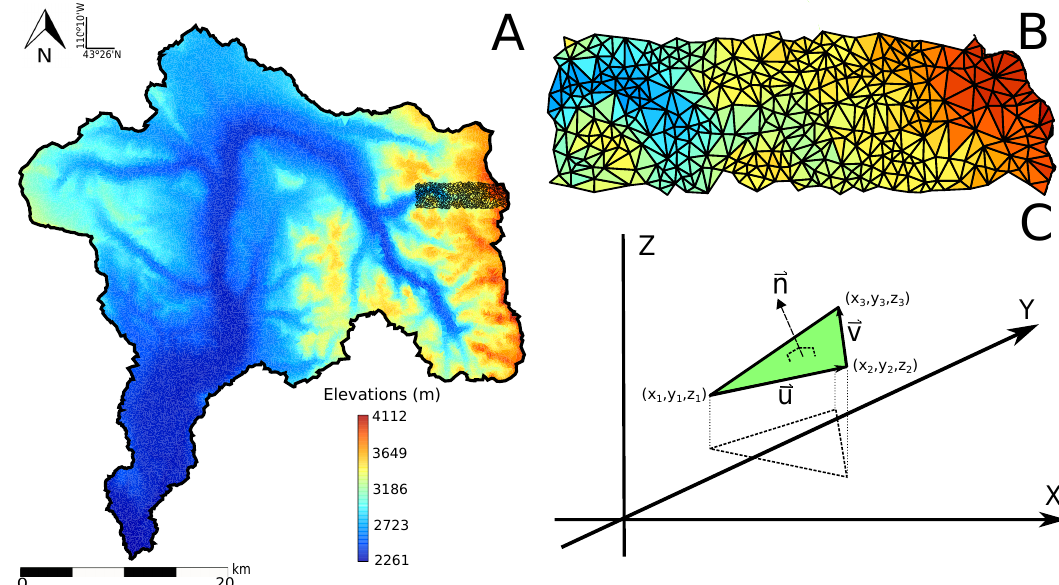
Figure 2. ( A ) Irregular-mesh model of study watershed; ( B ) Sample zoom region with TIN elements. Each triangle’s elevation is obtained from the mean of its three vertices’ values; ( C ) Normal vector to a triangular plane determined by the cross product of vectors (cid:126) u and (cid:126) v